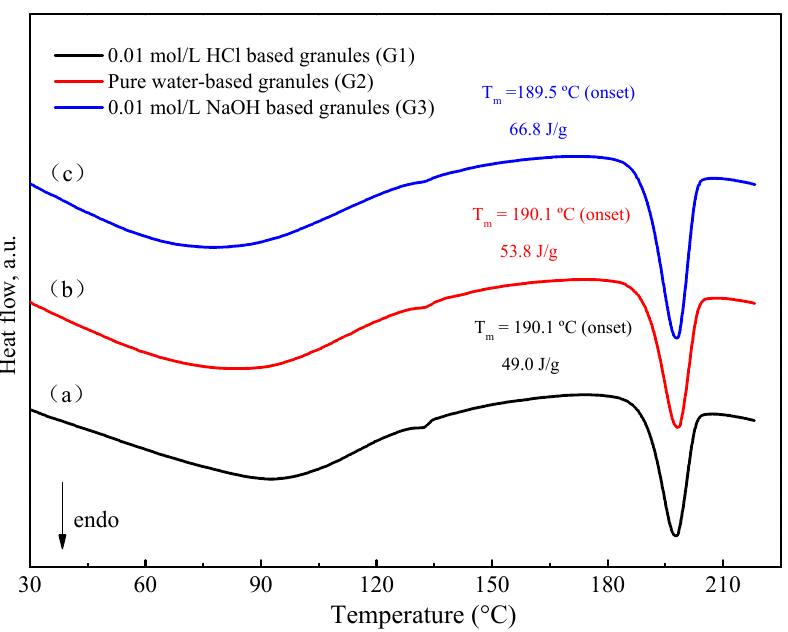
Figure 9. DSC thermogram of granule by wet ‐ granulation process with various solvents. ( a ) 0.01 mol/L HCl, ( b ) pure water, ( c ) 0.01 mol/L NaOH. The enthalpy values have been normalized for the FXD content in formulation. Table 3. Results of flow properties (mean ± SD, n = 3), hardness of tablets (mean ± SD, n = 6). Parameter